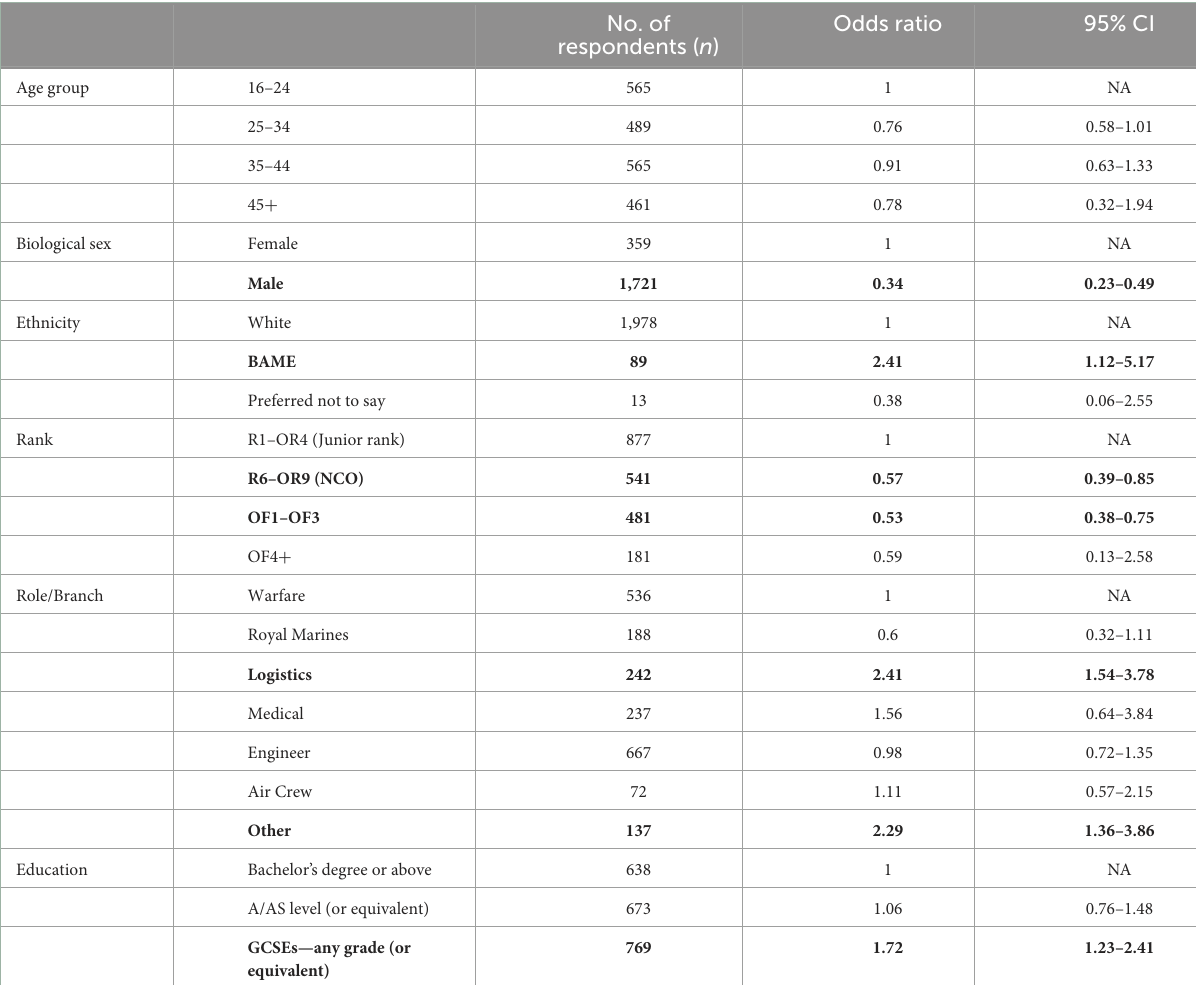
TABLE 2 Association between COVID-19 severity score and vaccine hesitancy by